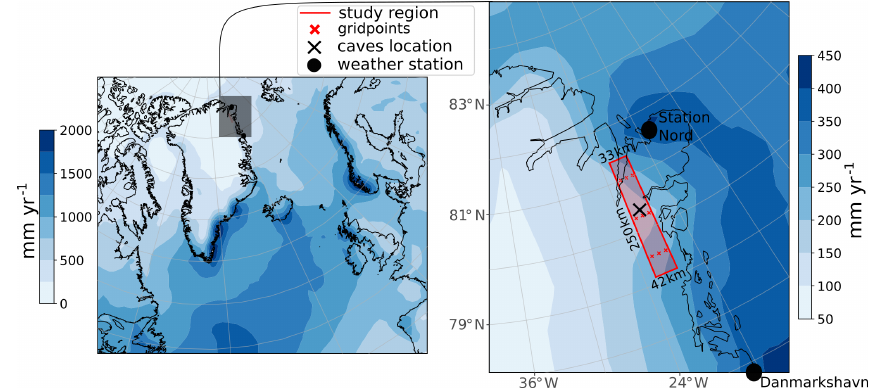
Figure 1. Average of yearly ERA-Interim precipitation (1979–2018). The study region is depicted with the nine grid points located between 22.5 and 21 ◦ W and between 79.5 and 81 ◦ N. The exact location of the studied caves is (80.3745 ◦ N, 21.7419 ◦ W). Average precipitation in